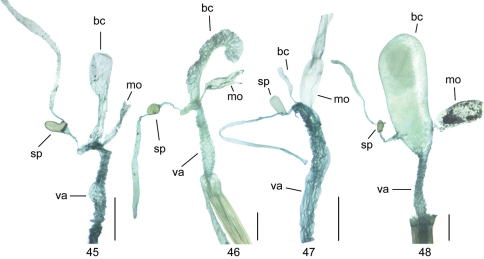
Female internal reproductive organs 45 Tillicera bibalteata, from Yunnan 46 Tillicera hirsuta, from Yunnan 47 Tillicera michaeli, from Guangdong 48 Tillicera cleroides, from Hainan. Abbreviations: bc = bursa copulatrix; mo = median oviduct; sp = spermatheca; sz = swollen zone; spd = spermathecal duct; spg = spermathecal gland; spgd= spermathecal gland duct; va = vagina.